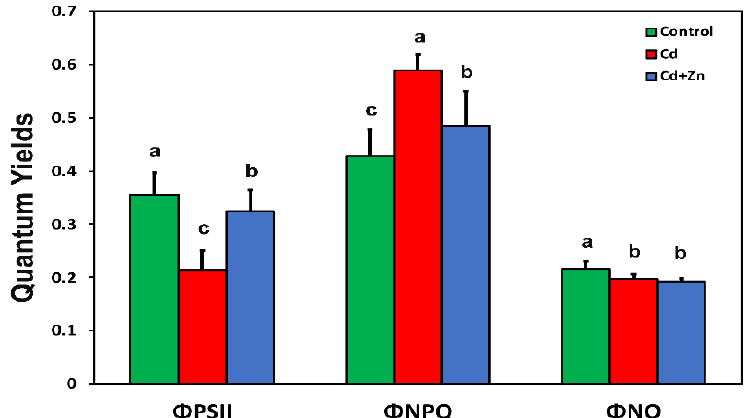
Figure 2. Changes in photosystem II quantum yields of Salvia sclarea control (nutrient solution), Cd 2+ (nutrient solution +100 μ M Cd 2+ ), and Cd 2+ + Zn 2+ (nutrient solution +100 μ M Cd 2+ + 900 μ M Zn 2+ ). Effective quantum yield of photochemistry ( Φ PS ΙΙ ), regulated non-photochemical energy loss ( Φ NPQ ), and non-regulated energy loss in PSII ( Φ NO ) at 900 μ mol photons m − 2 s − 1 actinic light (AL) intensity. Error bars are standard deviations ( n = 5). Columns in each chlorophyll fluorescence parameter with different lowercase letters are statistically different ( p < 0.05).